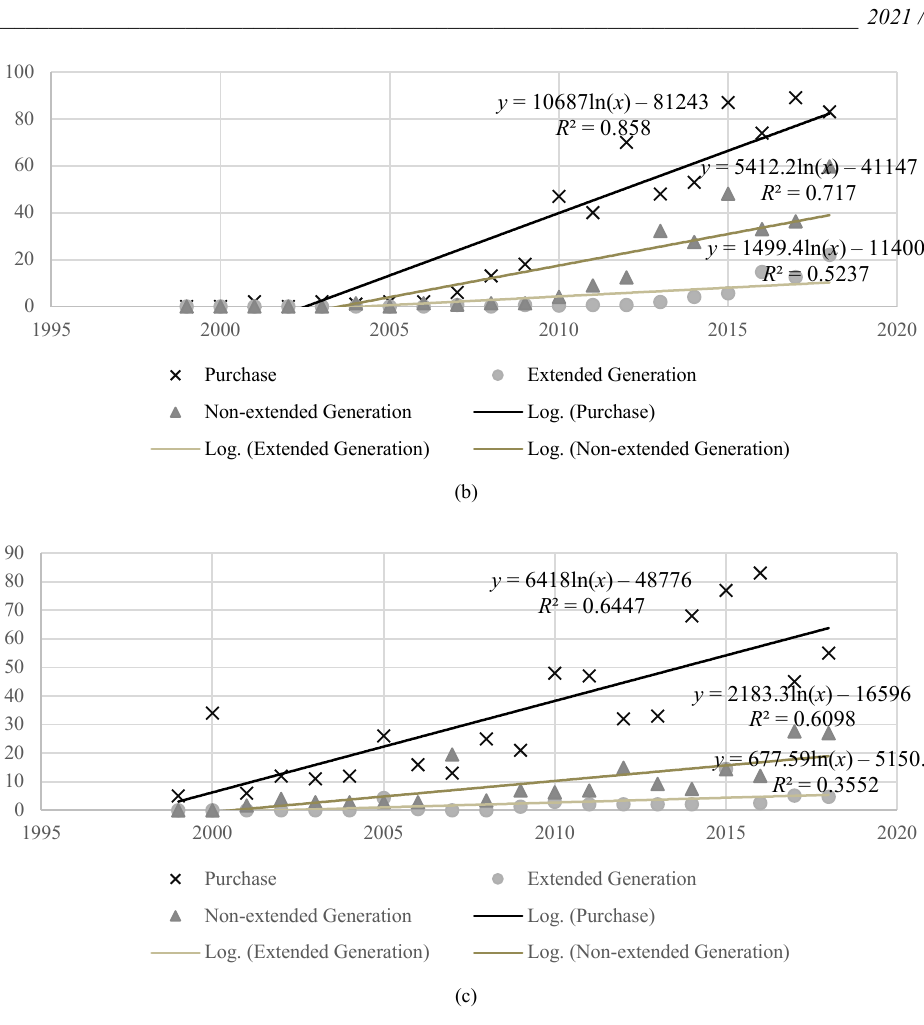
Fig. 4. Logarithmic Regression Chart of Purchase Data: a) mobile phones; b) laptops; c)